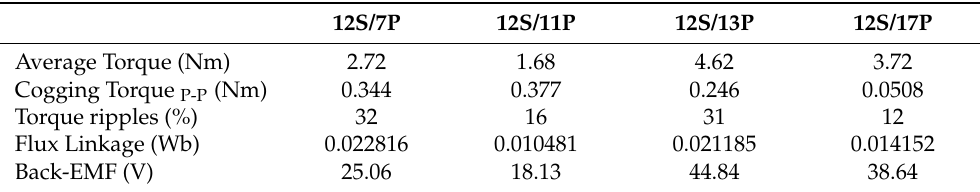
Table 2. Quantitative performance of the OR-FEFSM with various rotor pole numbers at J a = J e = 15 A/mm 2 .